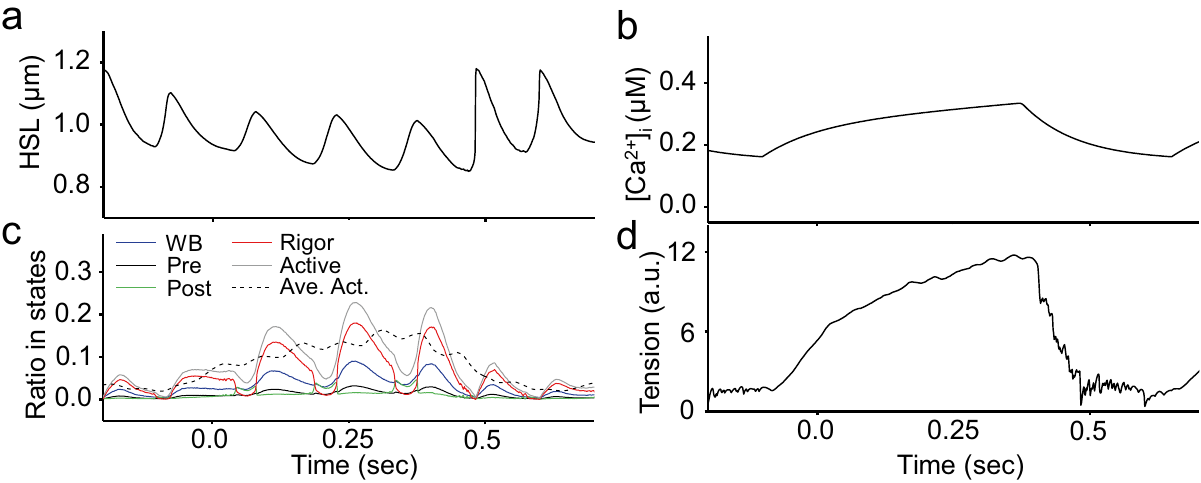
Figure 4. Parameter changes of the model that reproduces HSOs (part 1). The recording time was the same for ( a–d) . (a) Changes in half-sarcomere length. ( b) Changes in [Ca 2+ ]. ( c) Changes in the number of myosin molecules in each state. Blue, WB state; black, Pre state; green, Post state; red, Rig state. The ratio became 1 when the Det state was included. The sum of the numbers of myosin molecules in the Pre, Post, and Rig states is indicated by “Active (states)” (gray line). The average value of the active myosin of the 40 half-sarcomeres used in the model is indicated by “Ave. Act.” with a black dashed line. (d) Tension generated by the active myosin